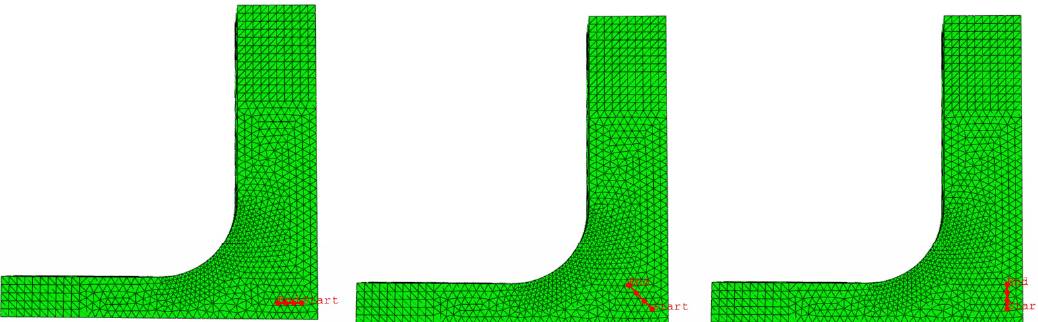
Figure 16. Paths at 0°, 45°, and 90° in geometry A for both loading scenarios.